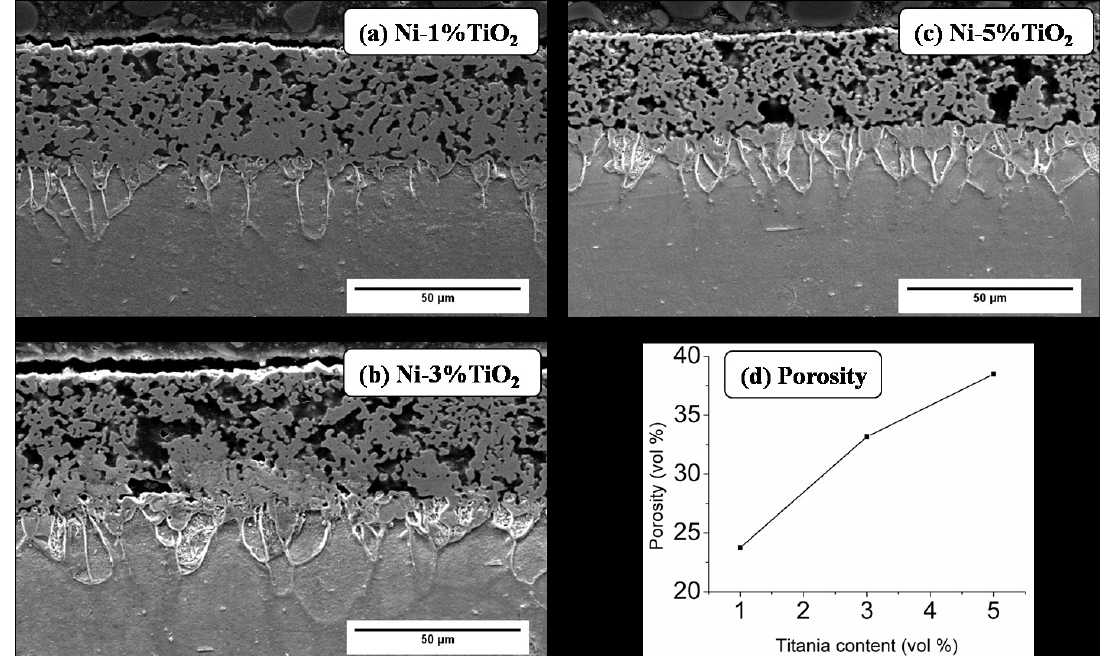
Figure 6: Influence of the nanotitania content on the adhesion of the coating and the final porosity of the Ni-TiO (b) Ni-3%TiO ; (c) Ni-5%TiO and; (d) porosity evolution according to the nano-TiO 2 2